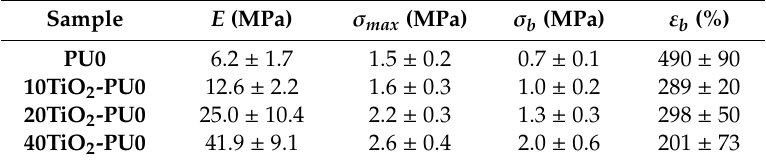
Figure 4. Atomic force microscopy (AFM) phase images (3 µm × 3 µm) of ( a ) PU0, ( b ) 10TiO 2 -PU0, ( c ) 20TiO 2 -PU0 and ( d ) 40TiO 2 -PU0. The inset in each AFM image corresponds to optical microscopy (OM) micrographs. Table 2. Young’s modulus ( E ), tensile strength ( σ max ), stress at break ( σ b ), and deformation at break ( ε b ) of PU0 and TiO 2 -PU0 nanocomposite